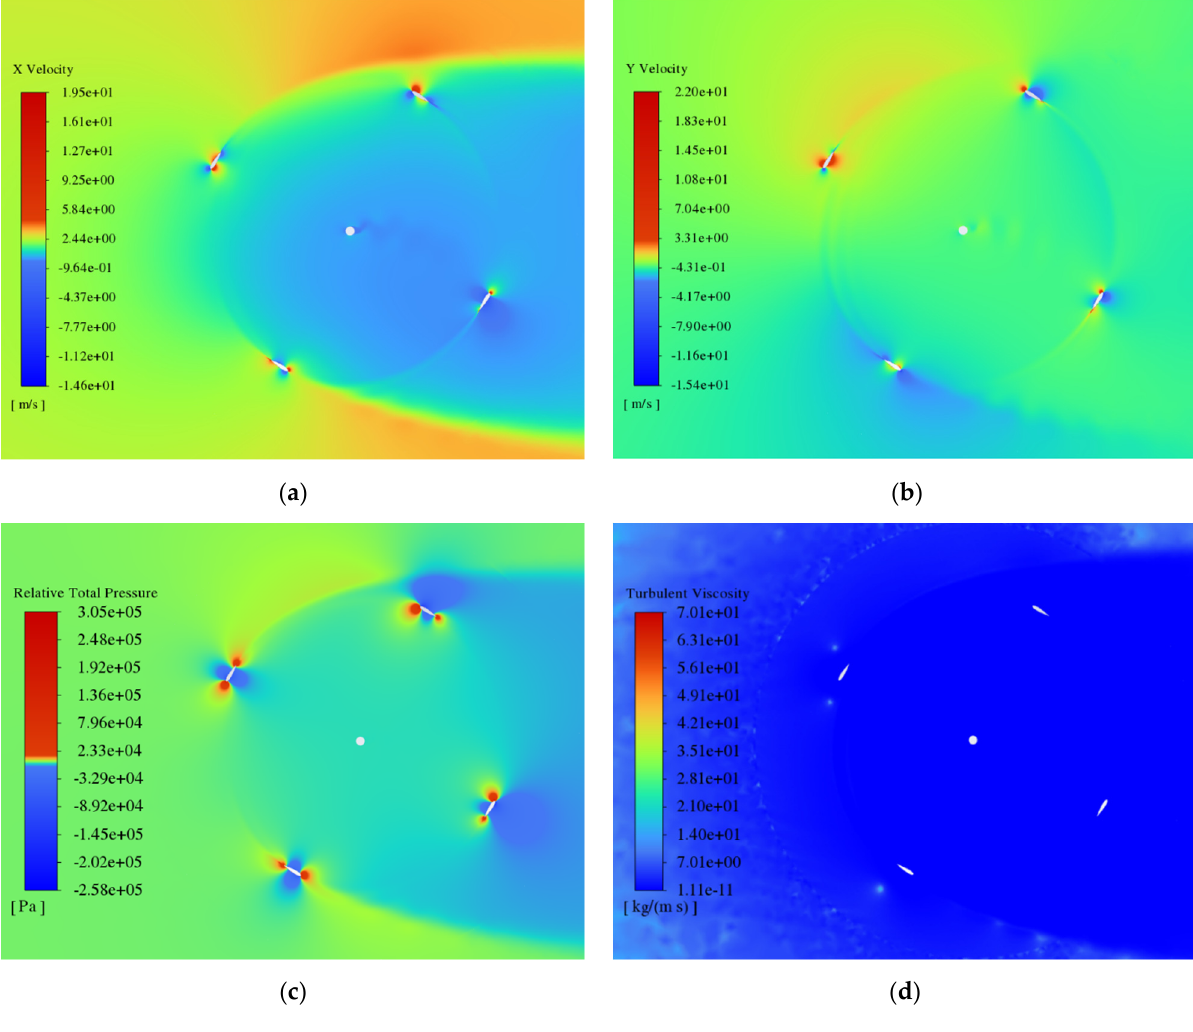
Figure 18. Flow field around the turbine rotor at v ∞ = 3.0 m/s, for the variables of ( a ) x-velocity, ( b ) y-velocity, ( c ) relative total pressure, and ( d ) turbulent viscosity.